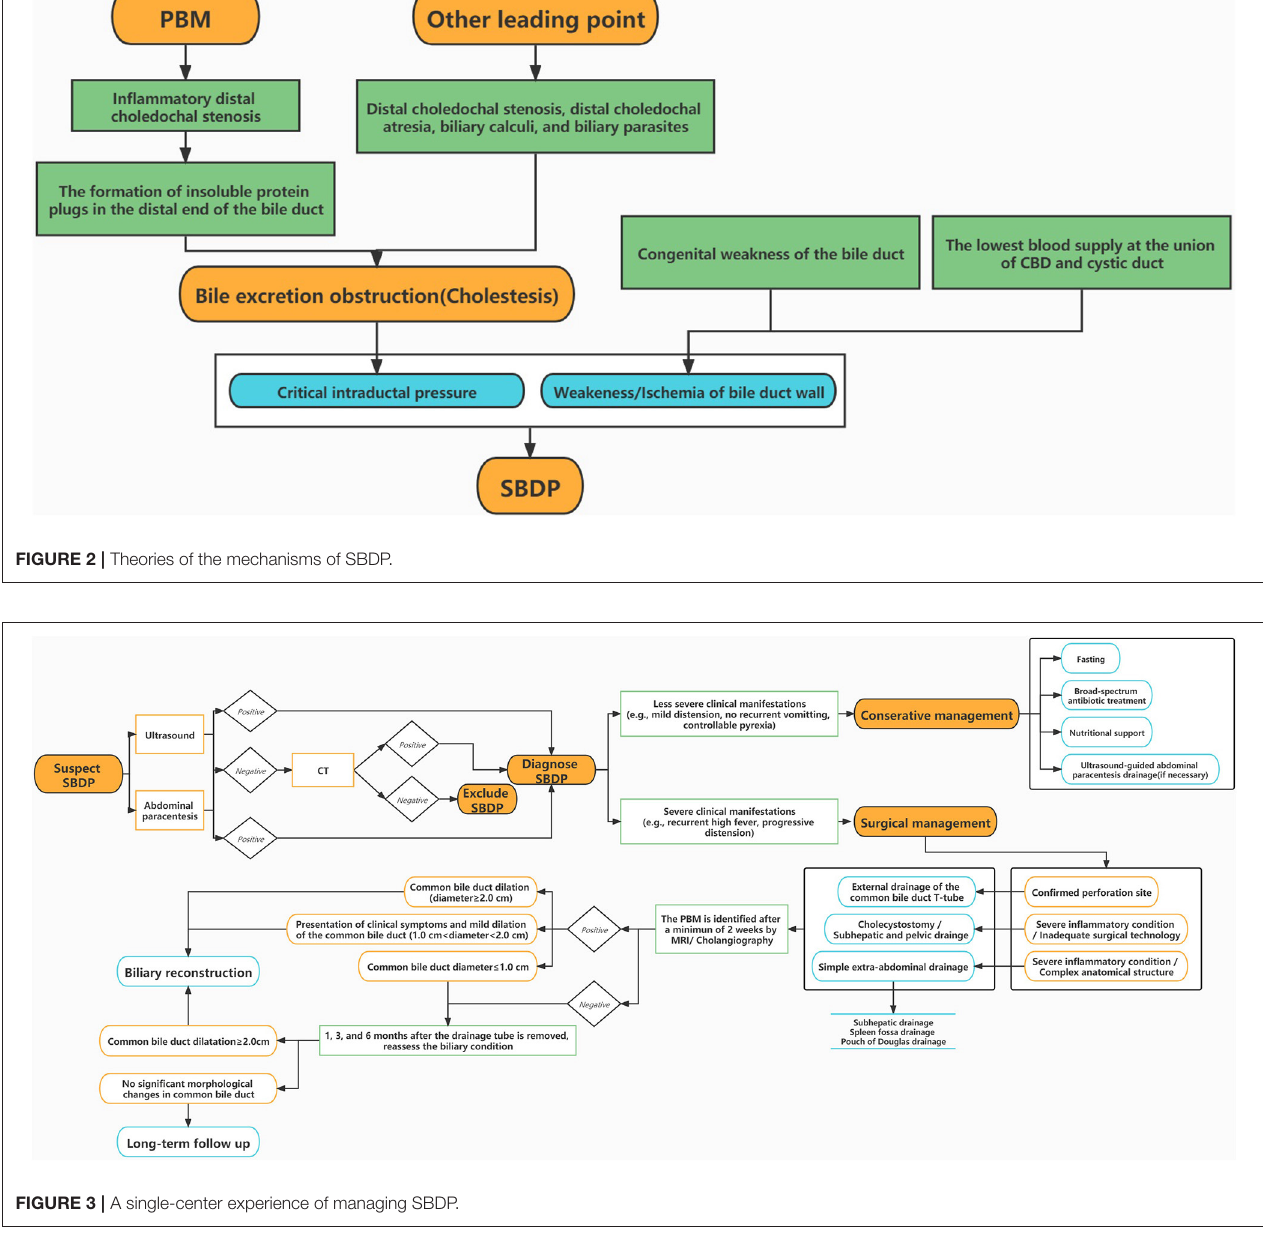
FIGURE 3 | A single-center experience of managing